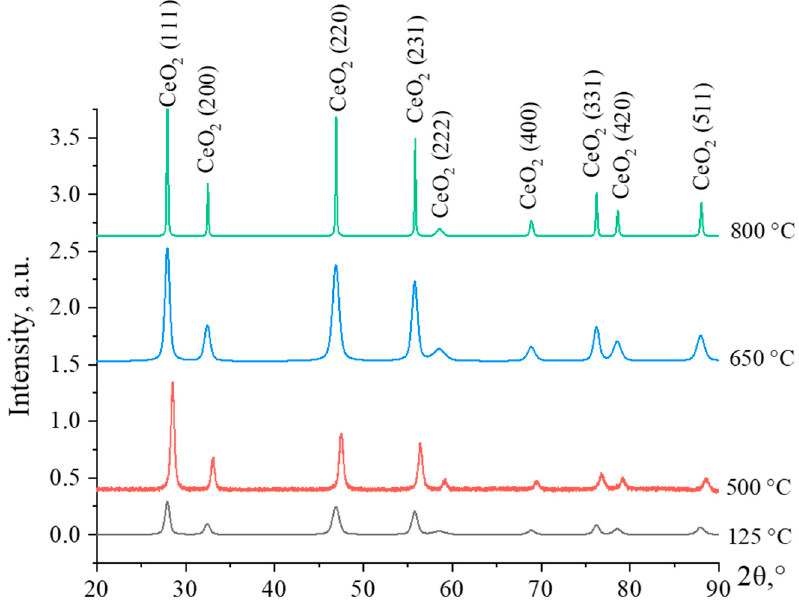
Figure 1. Di ff raction pa tt erns of cerium hydroxide samples, calcined at temperatures of 125, 500, Figure 1. Diffraction patterns of cerium hydroxide samples, calcined at temperatures of 125, 500, 650, 650, and 800 °C. and 800 ◦